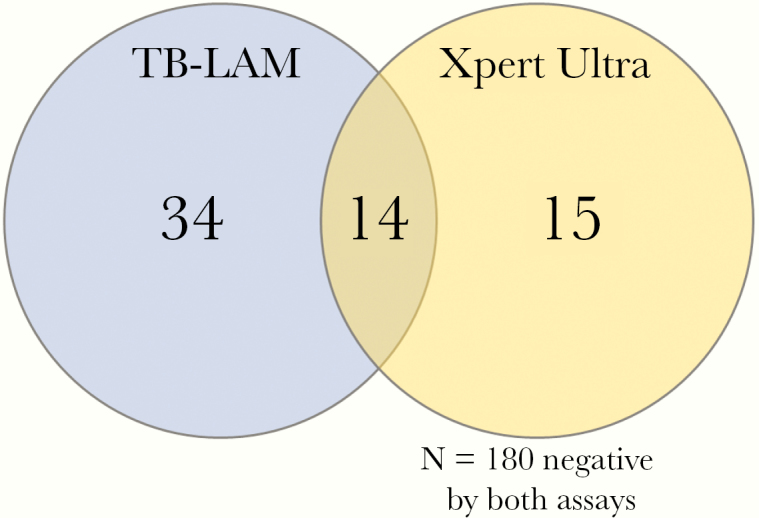
Venn diagram of overlap between tuberculosis (TB)-positive urinary assays. Of 243 persons with both TB-lipoarabinomannan (TB-LAM) and urine Xpert Ultra results, 63 were positive by either TB urinary assay, 76% (48 of 63) of whom were positive by TB-LAM and 46% (29 of 63) by Xpert Ultra (P = .01). Only 22% (14 of 63) of those with a positive urine TB test were positive by both TB-LAM and Ultra. Among the 195 persons with a negative TB-LAM, 15 (7.7%) were positive by Xpert Ultra, with a number needed to test with Ultra to diagnose an additional case of disseminated TB being 13 (95% CI, 8.0–22.9).